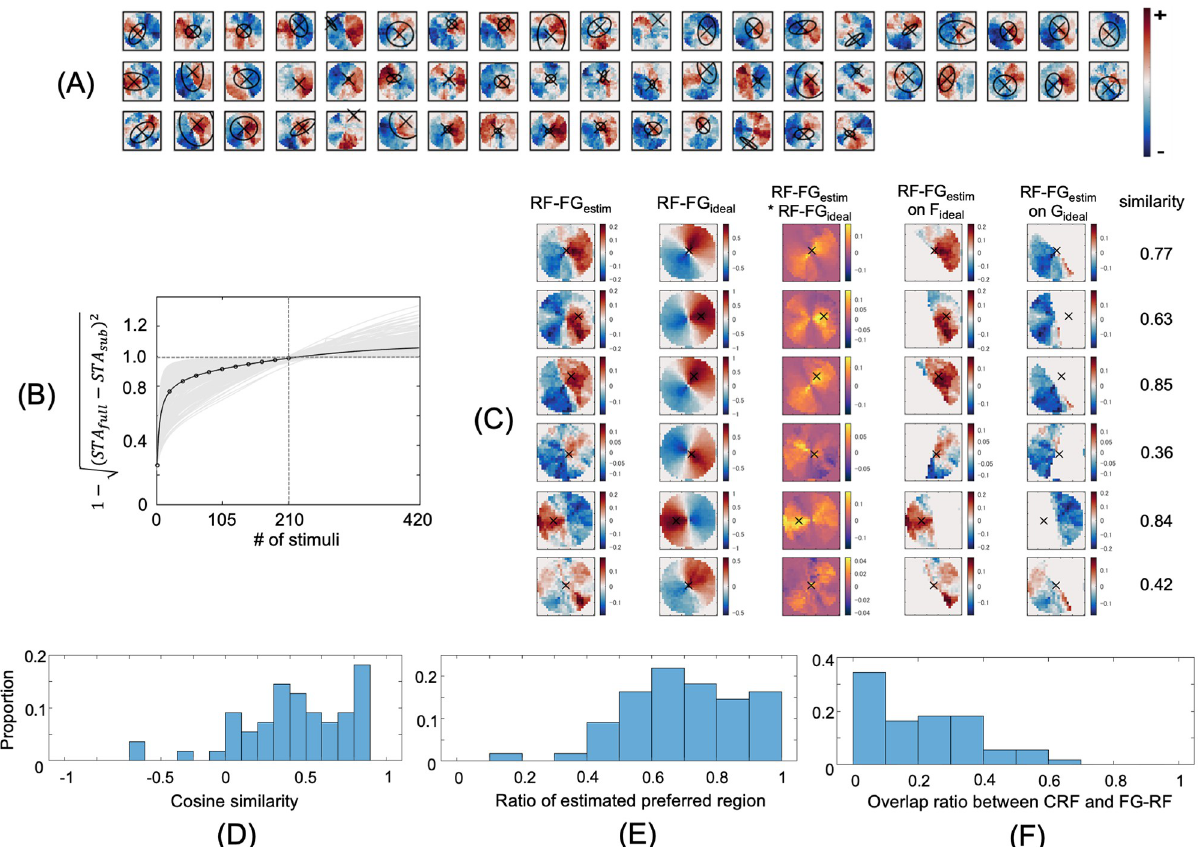
Fig 3. Estimated RF-FG STA s computed from the natural stimuli. The same conventions were used as in Fig 2. (A) Estimated RF-FG STA s. (B) Convergence of RF-FG STA magnitude. (C) Comparison between the estimated and ideal RF-FGs for six example neurons with preference to figure. (D) Distribution of the cosine similarity. (E) Distribution of the ratio between the extents of the estimated preferred-region and that of the ideal preferred- region. (F) Distribution of the overlap ratios between the extents of the CRFs and preferred regions. The RF-FG STA s computed from the natural stimuli exhibited similar characteristics to the RF-FG STA s computed from the filled stimuli.